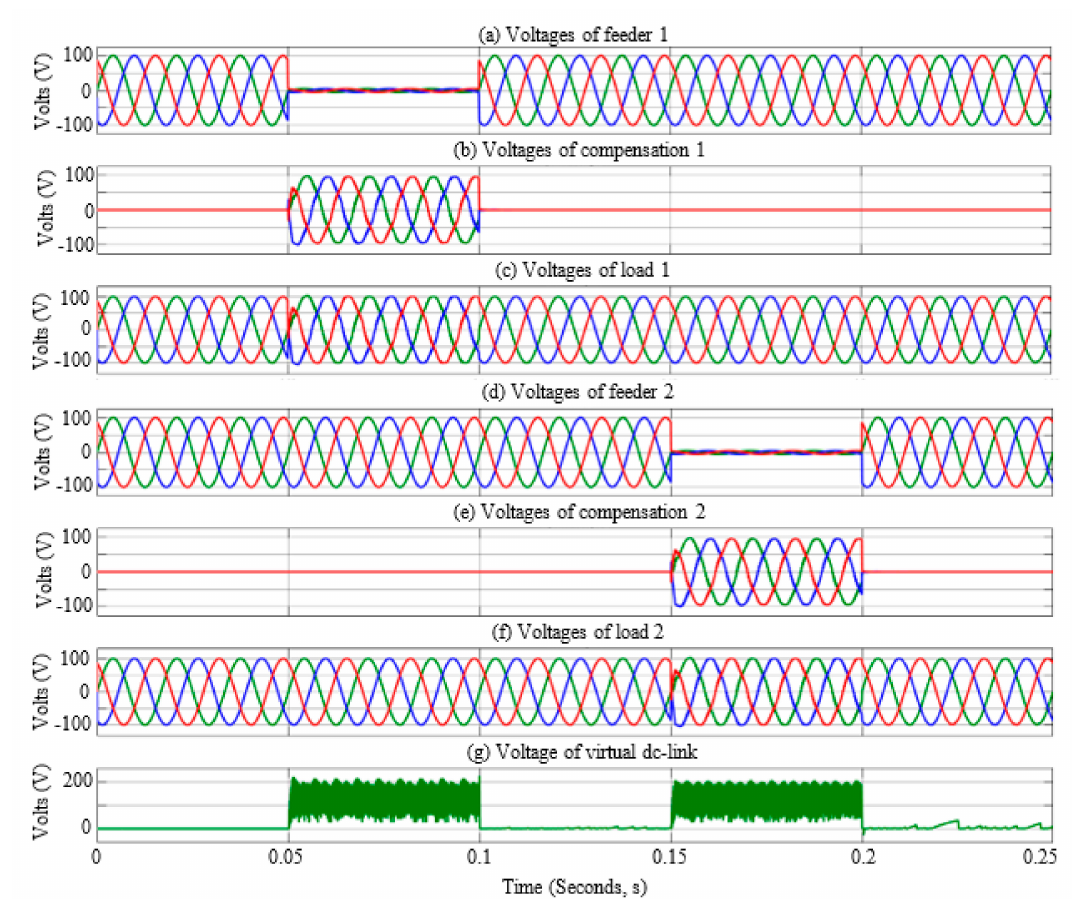
Figure 15. System waveforms in the voltage interruption compensation. ( a – c ) Waveforms of feeder 1; ( d – f ) waveforms of feeder 2; ( g ) virtual dc-link voltage